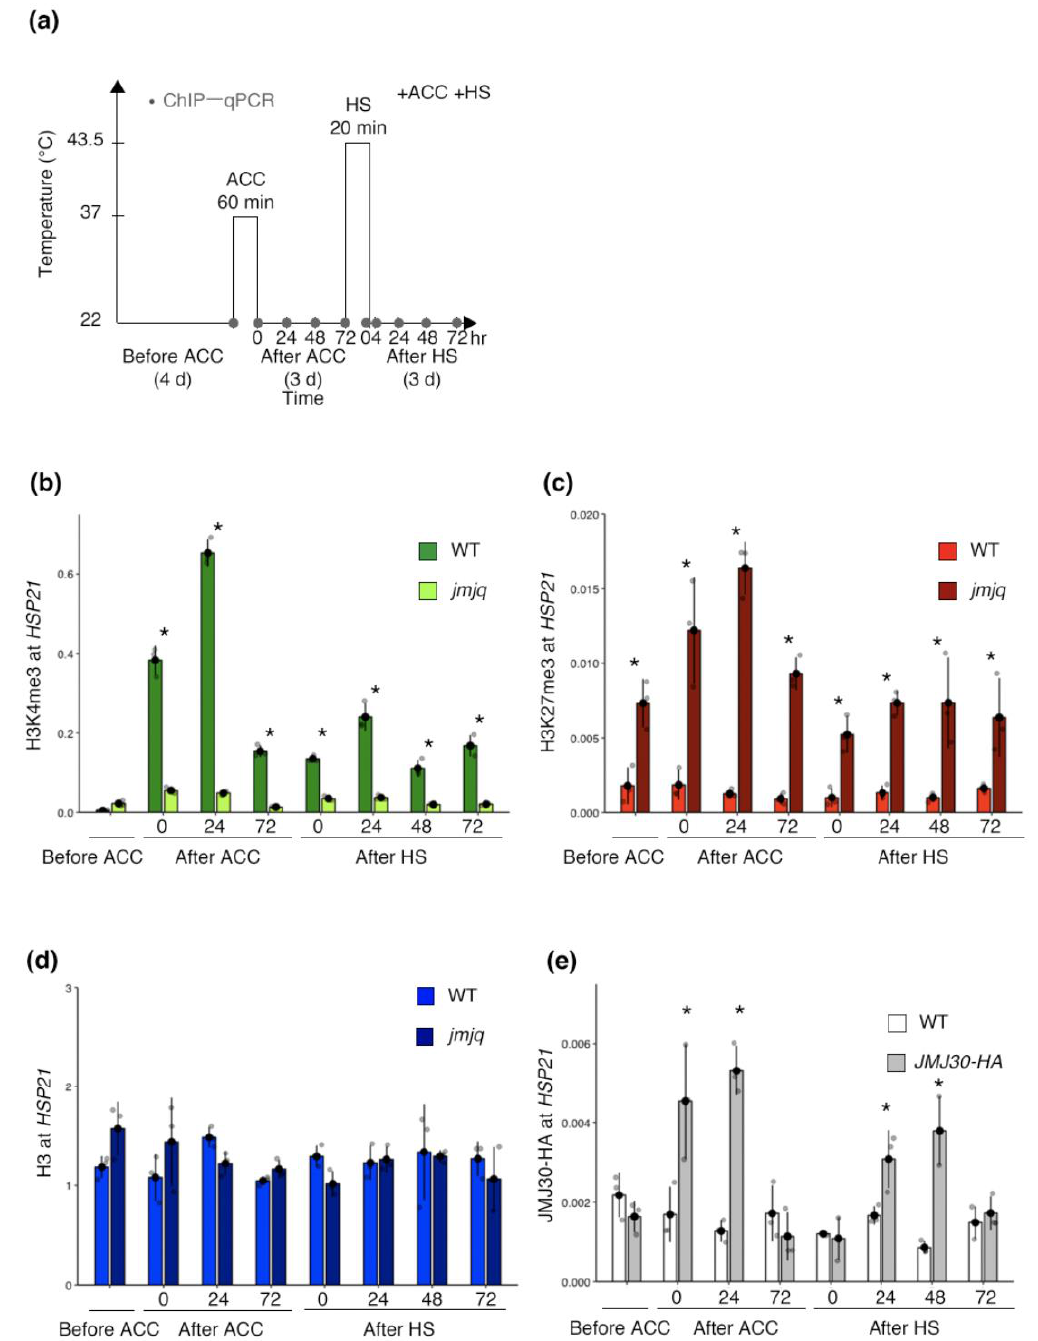
Figure 2. Jumonji 30 directly bound to the HSP21 locus in response to heat for maintenance of the H3K4me3 and H3K27me3 balance. ( a ) Schematic representation of the temperature conditions used. Timing of ChIP–qPCR is denoted by grey dots. ( b–e ) H3K4me3 ( b ), H3K27me3 ( c ), and histone H3 ( d ) levels in the wild type (WT) and jmjq mutants, and JMJ30-HA ( e ) levels at the HSP21 gene as determined by ChIP–qPCR. Gray jitter dots represent the expression level in each sample. Asterisks indicate significant difference at 0.05 levels based on Student’s t -test between the wild type and jmjq mutants at the same time point. NS, not significant; ACC, acclimation; HS, heat